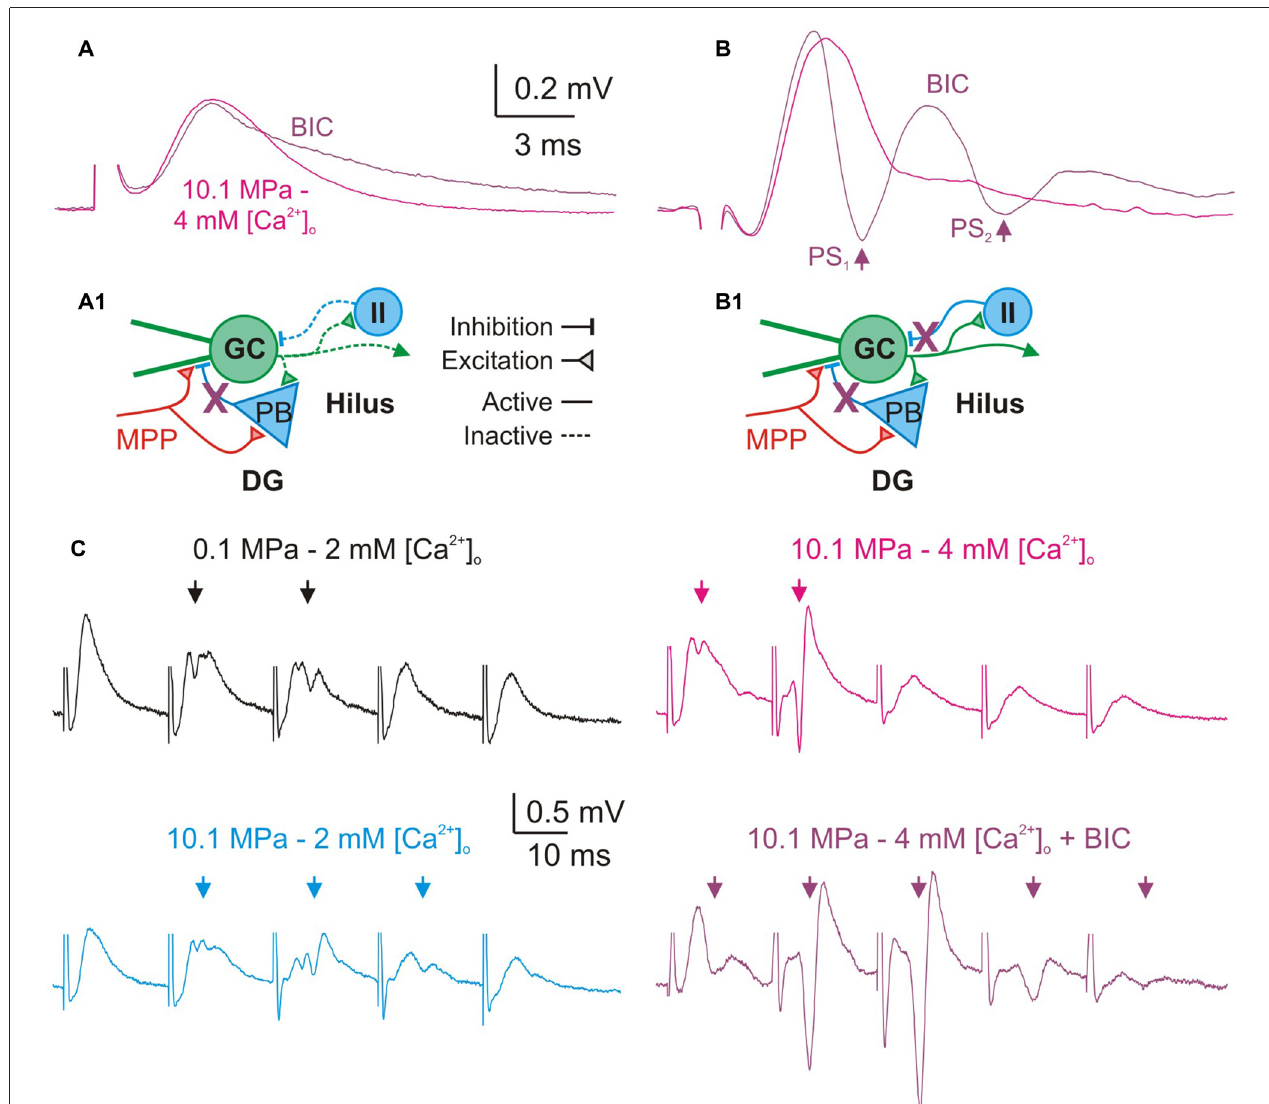
FIGURE 7 | Blockade of GABA A —inhibition increases DG excitability and prevents its restraint by high [Ca 2 + ] o . (A,B) Effect of GABA A receptors blockade on single fEPSPs. Bicuculline (BIC, 10–20 µ M) prolongs the duration of subthreshold fEPSPs produced by weak MPP stimulation (A) , and produces larger PS and repetitive PS firing (arrows) by moderate/intermediate intensity fEPSPs (B) . (A1,B1) Schematics of a simplified DG network showing basic excitatory and inhibitory elements, suspected targets of GABA A blockade (X), and their consequences for the activity of the network. (A1) Blockade of feed-forward inhibition prolongs MPP fEPSPs. During subthreshold MPP fEPSPs stimulation (A) the MPP directly excites the GC and the PB producing a monosynaptic fEPSP which is succeeded by a PB’s di-synaptic IPSP which inhibits the late portion of the EPSP. Blockade of inhibition prolongs the duration of subthreshold fEPSPs. (B1) Blockade of feed-forward and feedback inhibition produce repetitive firing by supra-threshold MPP fEPSPs. Stronger MPP fEPSP produces a PS that activates feedback inhibitory interneurons (II) suppressing repetitive firing. Thus, blockade of feedback GABA A produces anomalous PS repetitive firing by single fEPSPs. (C) GABA A receptors blockade prevents high [Ca 2 + ] o —mediated restriction of PS 1 − 5 generation during trains of moderate/intermediate intensity fEPSPs at 50 Hz. Note the significant increase in the amplitude and number of PS elicited by the E 1 − 5 train at 10.1 MPa–4 mM [Ca 2 + ] o after blockade of fast inhibition despite of the preserved FDD of the fEPSPs